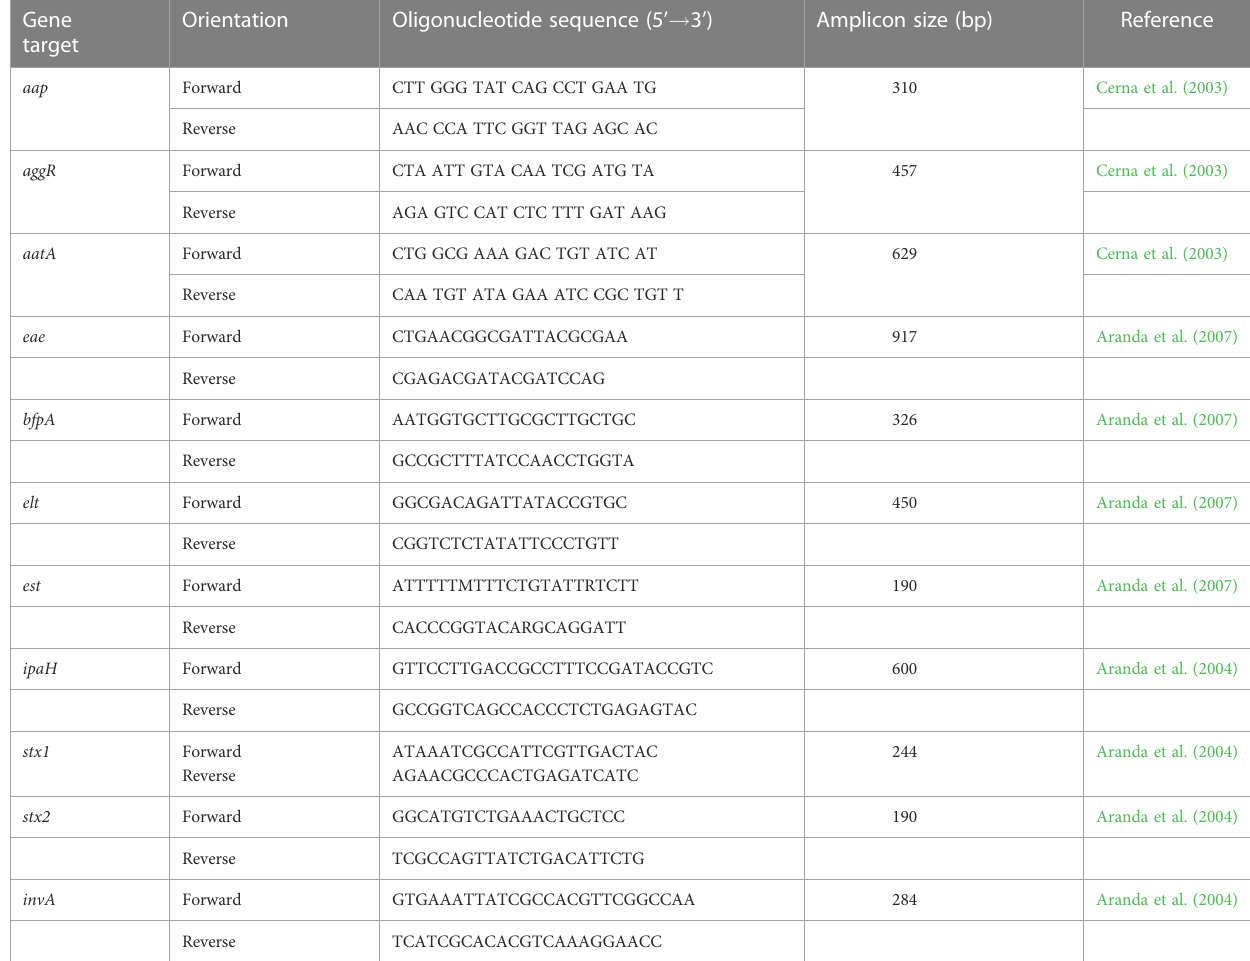
TABLE 1 Primer information of target